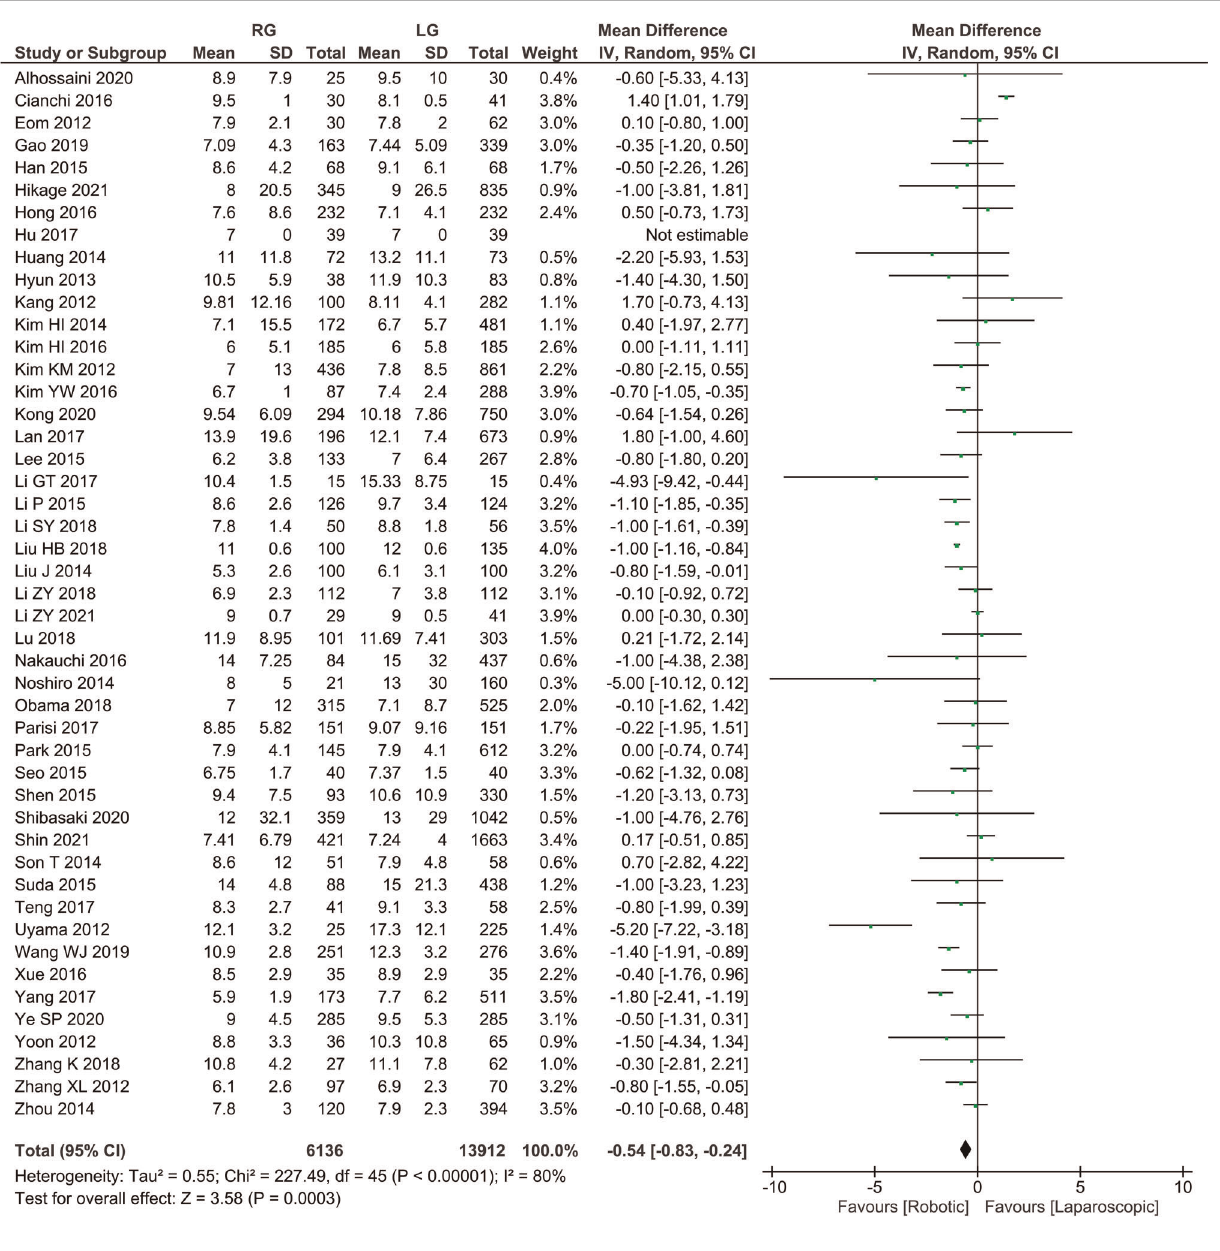
FIGURE 6 | Comparison of length of postoperative hospital stay between RG and LG